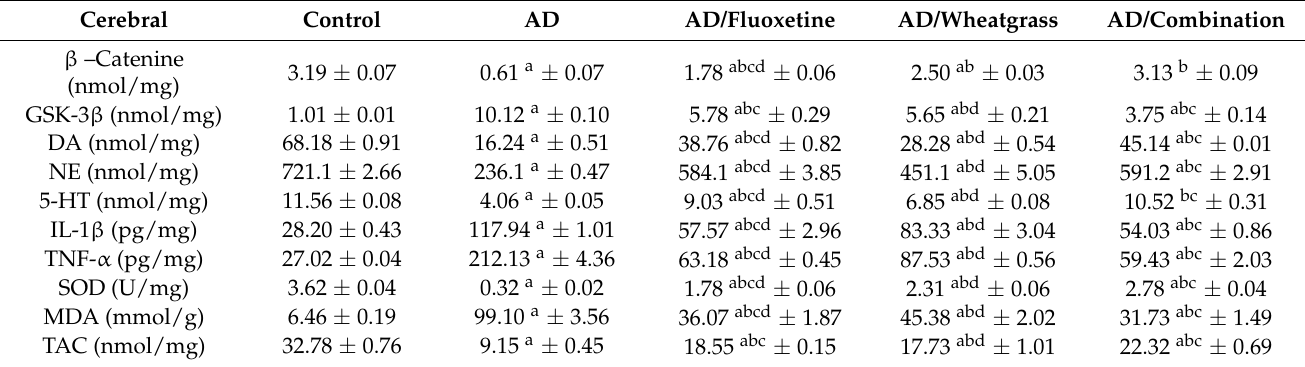
Number of animals in each group ( n = 10). Data were expressed as means ± SD. ab,c, or d ; Significantly different from the control, AD, wheatgrass/AD, or combination/AD group, respectively, p < 0.05 using ANOVA followed by Tukey–Kramer as post hoc